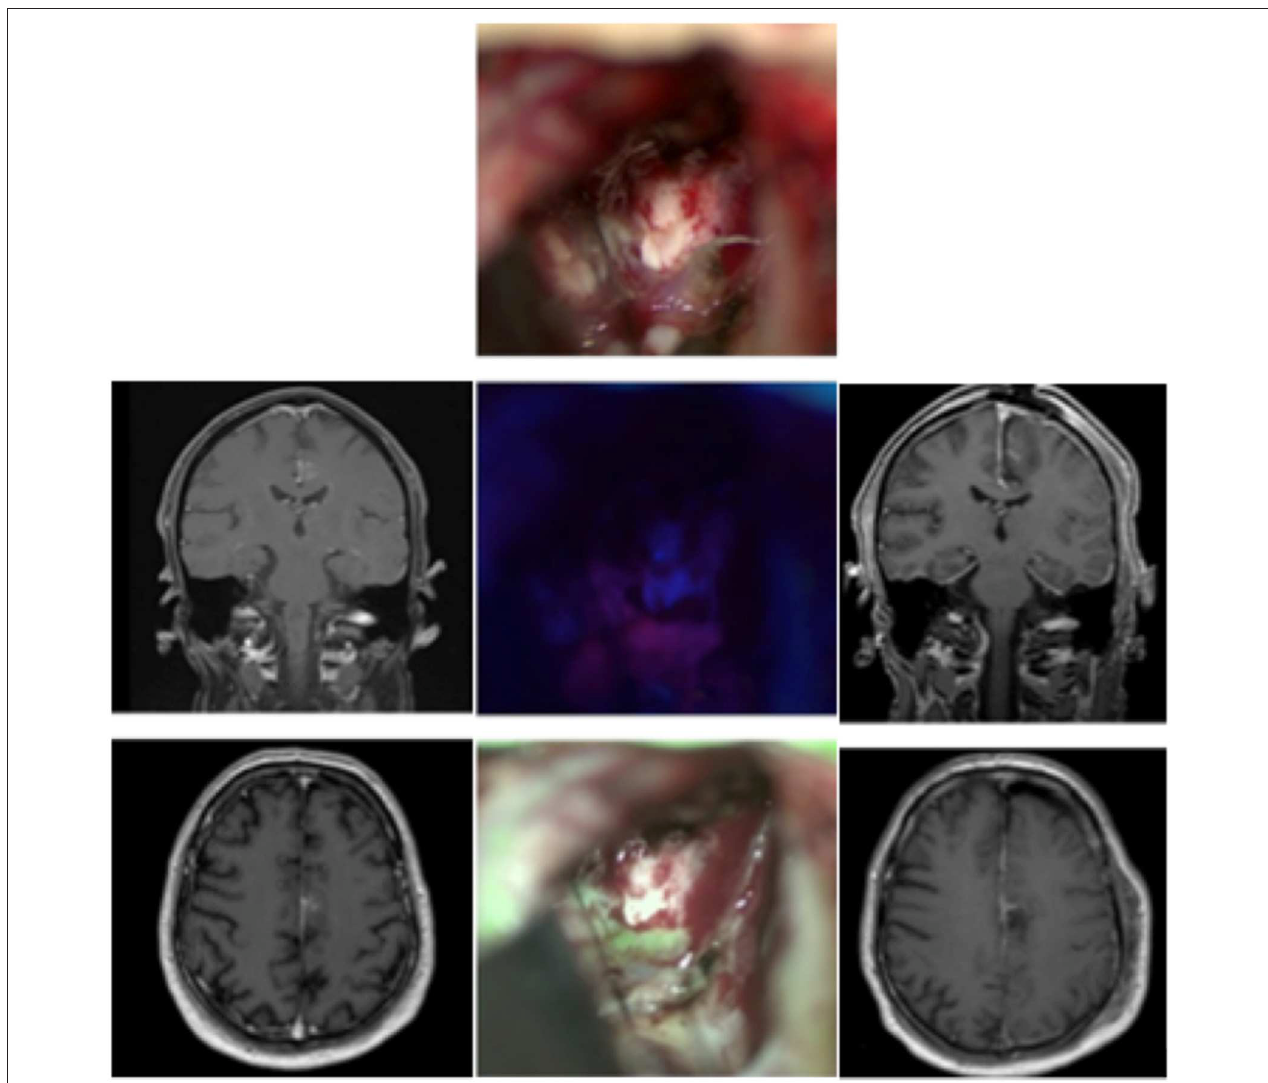
FIGURE 2 | Anaplastic astrocytoma in a 65-year-old patient. The left side shows the preoperative MRI (contrast-enhanced), while the right column shows the early 48 h-postoperative MRI. In the middle column the operative cavity shows the field under white light, below it under blue light, and at the bottom the fusion of both images in the